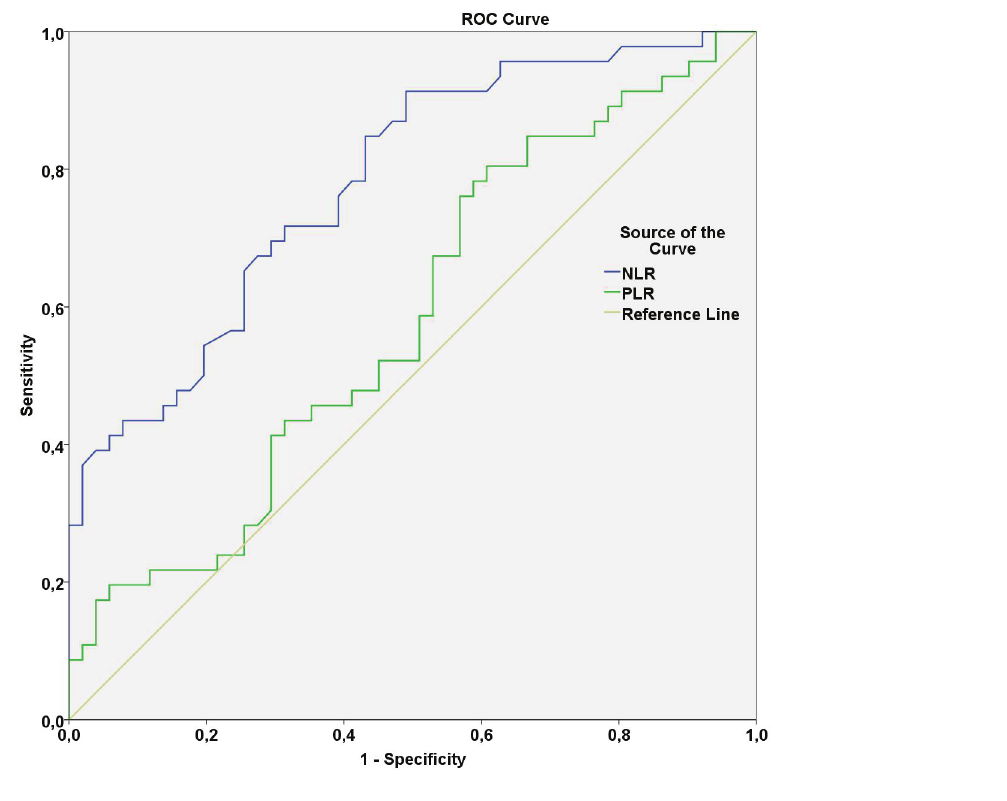
Figure 1. ROC curve analysis of NLR and PLR in RAO patients. NLR was determined to be more sensitive and had higher rate as a predictor of inflammation compared to PLR. AUC for NLR: 0.780, cut-off value: 1.82, sensitivity: 72%, specificity: 69%. (95% CI: 0.690–0.871). AUC for PLR: 0.582, cut-off value: 92.35, sensitivity: 67%, specificity: 57%. (95% CI: 0.468–0.696). AUC, area under the ROC curve; NLR: neutrophil-to-lymphocyte ratio; PLR platelet-to-lymphocyte ratio; RAO: retinal artery